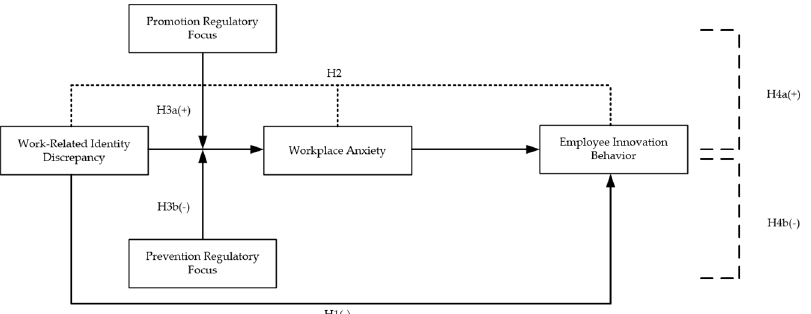
Figure 1. The research conceptual model.